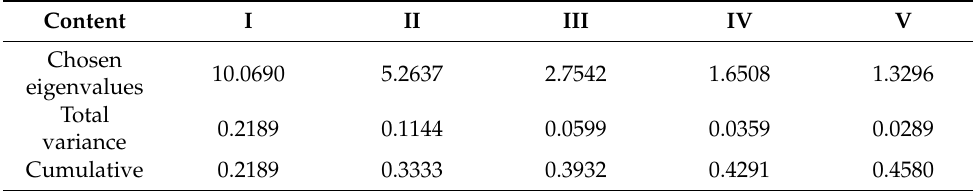
Table 4. Eigenvalues and explanatory variances in the classification of five types.